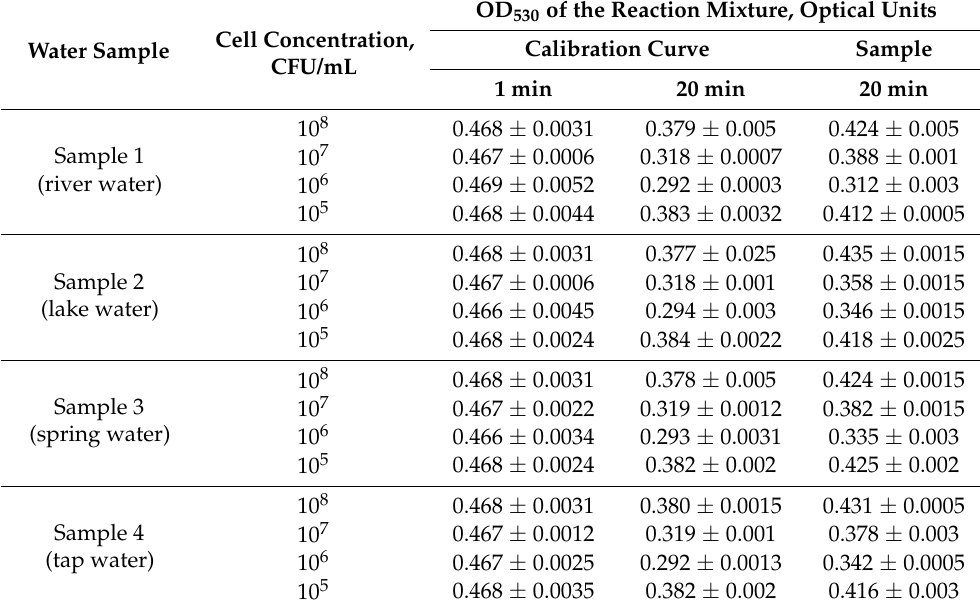
Table 6. OD 530 values in water samples spiked with F. tularensis subsp. holarctica 15 NIIEG cells at concentrations of 10 8 , 10 7 , 10 6 , and 10 5 CFU/mL after 1 and 20 min of the agglutination reaction. OD 530 of the Reaction Mixture, Optical Units Cell Concentration, Calibration Curve Sample Water Sample CFU/mL 1 min 20 min 20 min 10 8 0.468 ± Sample 1 (river water)